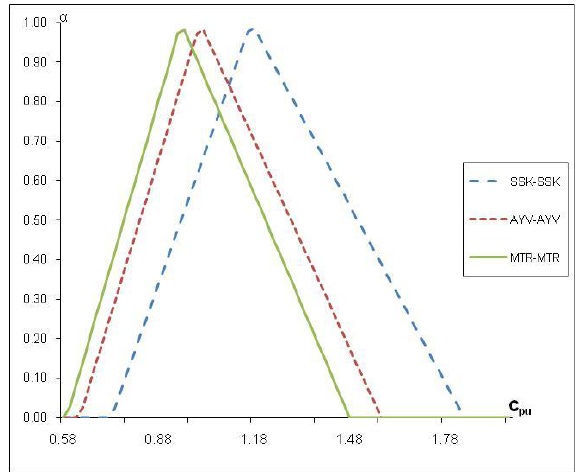
Fig. 10. The membership functions of the index for three stations of route